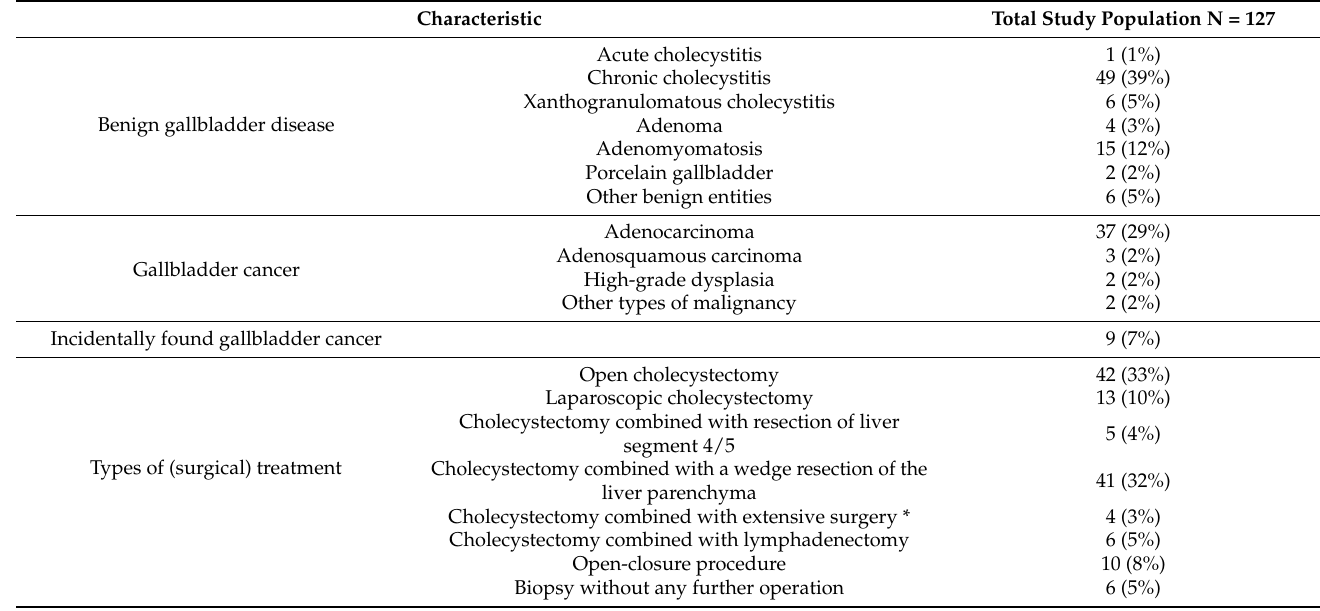
Table 1. Histopathology results and treatment data.